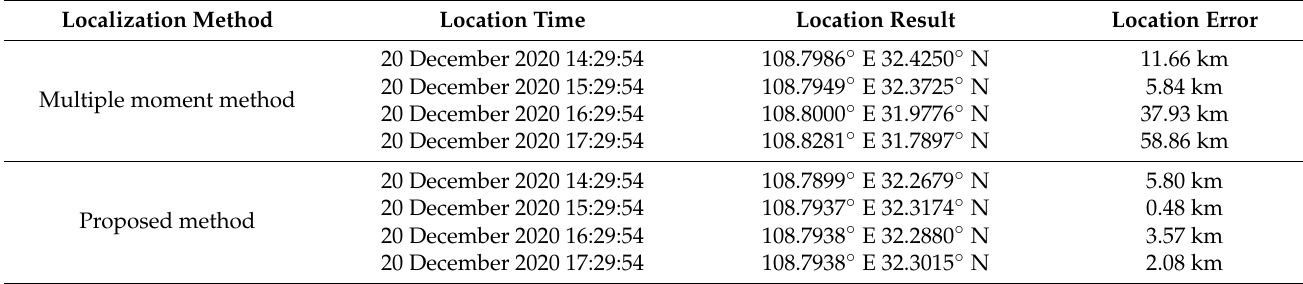
Table 1. Location results and location errors of the multiple time method and the proposed method. Localization